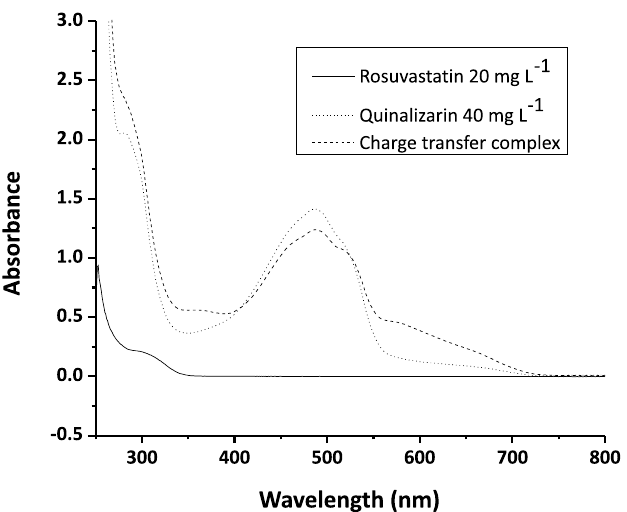
FIGURE 3 - Absorption spectra of rosuvastatin 20 mg L -1 , quinalizarin 40 mg L -1 and the radical anionic, all DMSO in solutions.